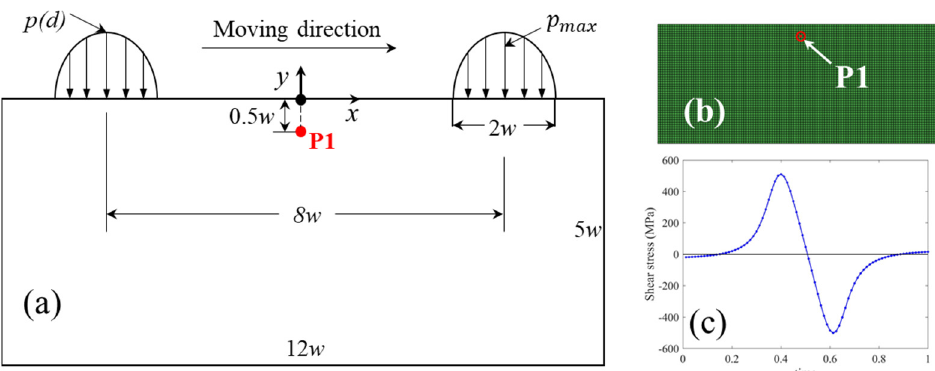
Figure 3. Shear stress on the subsurface under rolling contact load. ( a ) Dynamic Hertz contact load setting. ( b ) FEM model and the location of point P1. ( c ) Change curve of shear stress at Point P1.